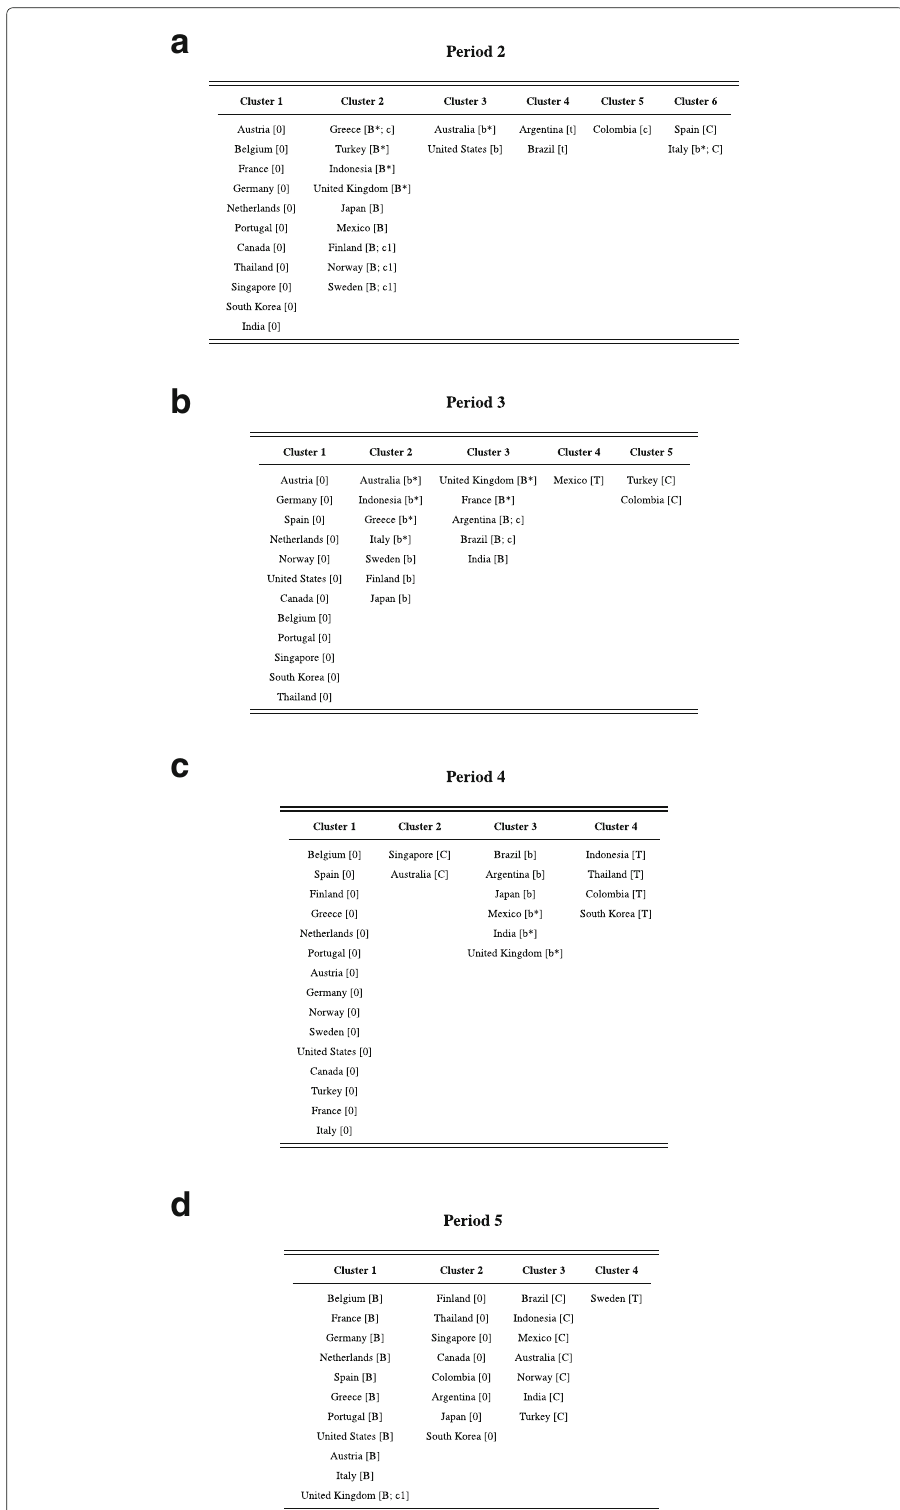
Fig. 3 Targeted Cluster-Composition: